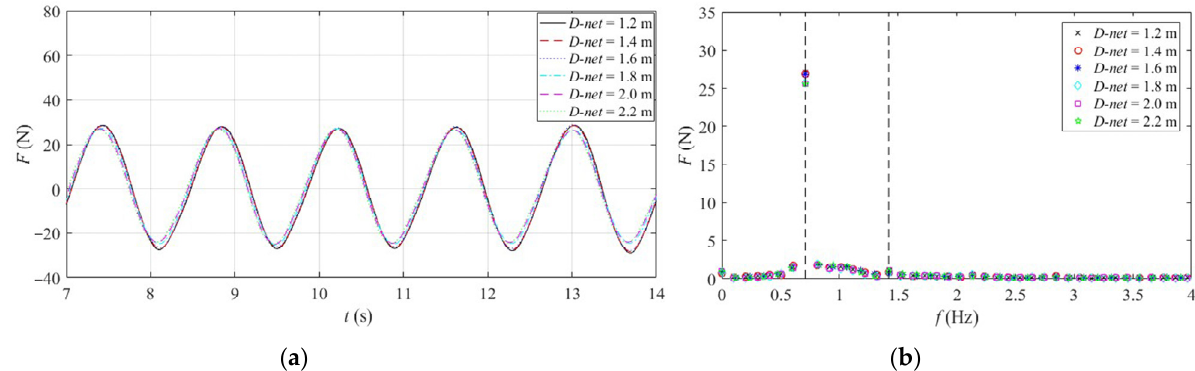
Figure 10. Load duration curve and spectrum of combined structure under different diameters of the cages. ( a ) Time domain curve. ( b ) Frequency domain diagram.